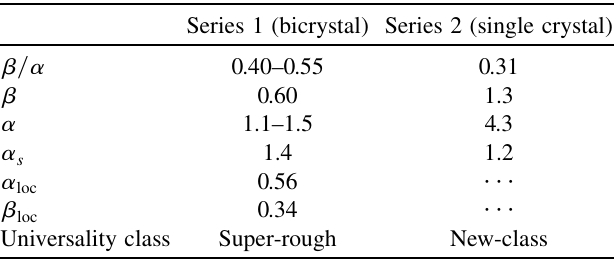
TABLE I. Overview of scaling results for each thin film thick- ness series.